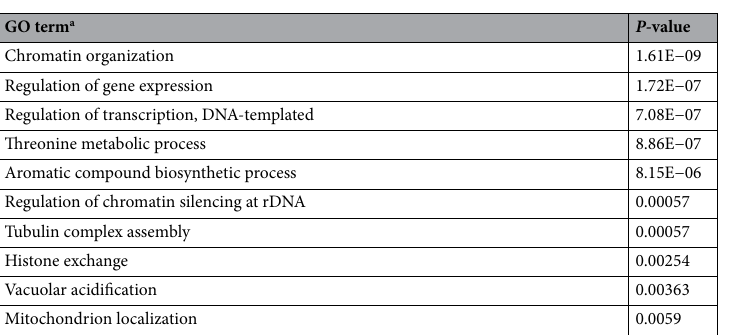
Figure 1. Biological pathways associated with the response to Ni(S-tcitr) 2 in yeast. ( a ) Interaction maps of the genes that cause Ni(S-tcitr) 2 sensitivity or resistance when deleted, generated with the functional annotation tool DAVID and visualized with the Enrichment Map plugin of Cytoscape. ( b–d ) same as ( a ) but applied to the indicated gene networks (‘chromatin/transcription’, ‘tubulin complex assembly’ and ‘Thr metabolism’ in panels b, c and d, respectively) and visualized with the Cytoscape (GeneMANIA plugin). Red and green nodes indicate genes that confer either Ni(S-tcitr) 2 resistance or sensitivity when deleted. Each node represents a functional category (e.g., a GO term or a KEGG pathway) and the width of the edges increases with the degree of gene overlap between the two connected categories; node size increases with the number of genes annotated to each functional category.